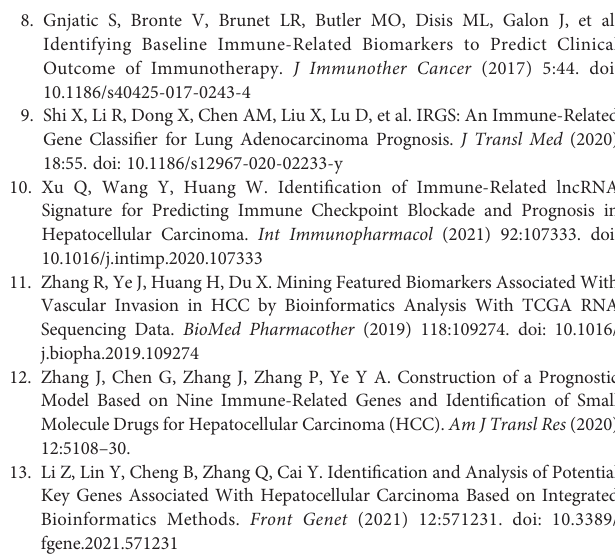
Supplementary Figure 1 | Relationships between clinical tumor histologic grade with expression of the eight immune ‐ related genes. CHGA (A) , RAET1E (B) , FGF9 (C) , GIP (D) , NR0B1 (E) , IL20RA (F) , ESRRG (G) , GNRH2 (H)